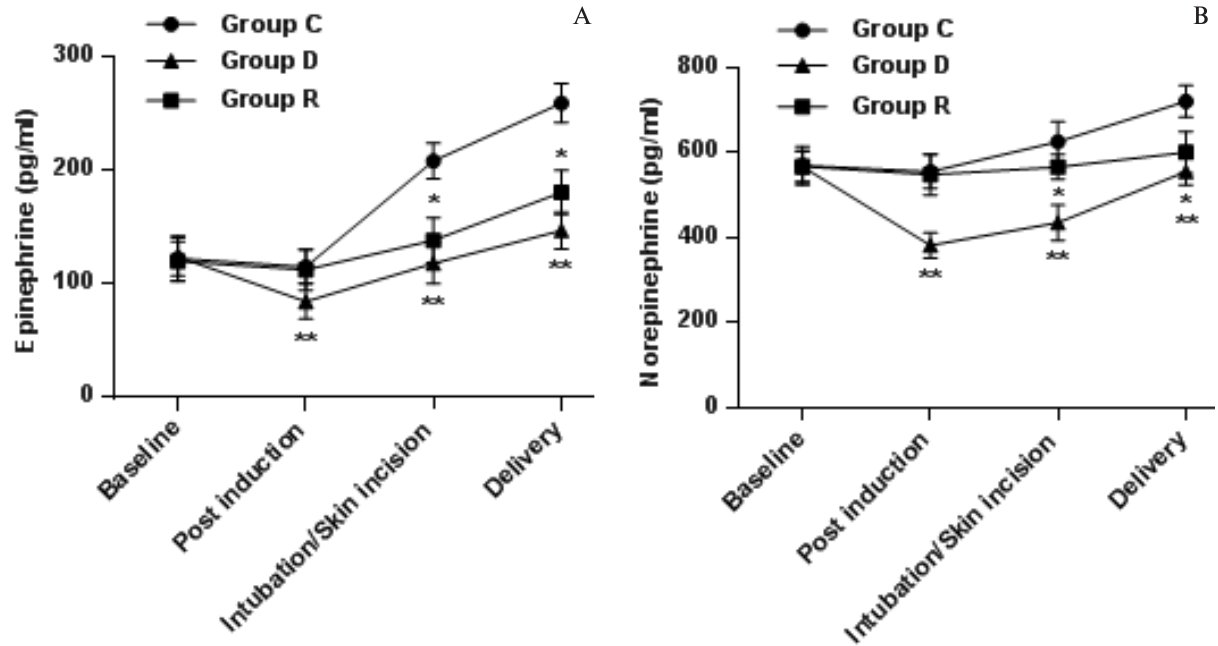
Fig. 3. The epinephrine and norepinephrine concentrations in the three groups. Compared with the control group, the epinephrine and norepinephrine concentrations were significantly lower in remifentanil group at intubation/skin incision and delivery, * P <0.05. Compared with the control and remifentanil group, the epinephrine and norepinephrine concentrations were significantly lower in dexmedetomidine group at post induction, intubation/skin incision and delivery, ** P <0.05. Values are presented as the mean ± standard